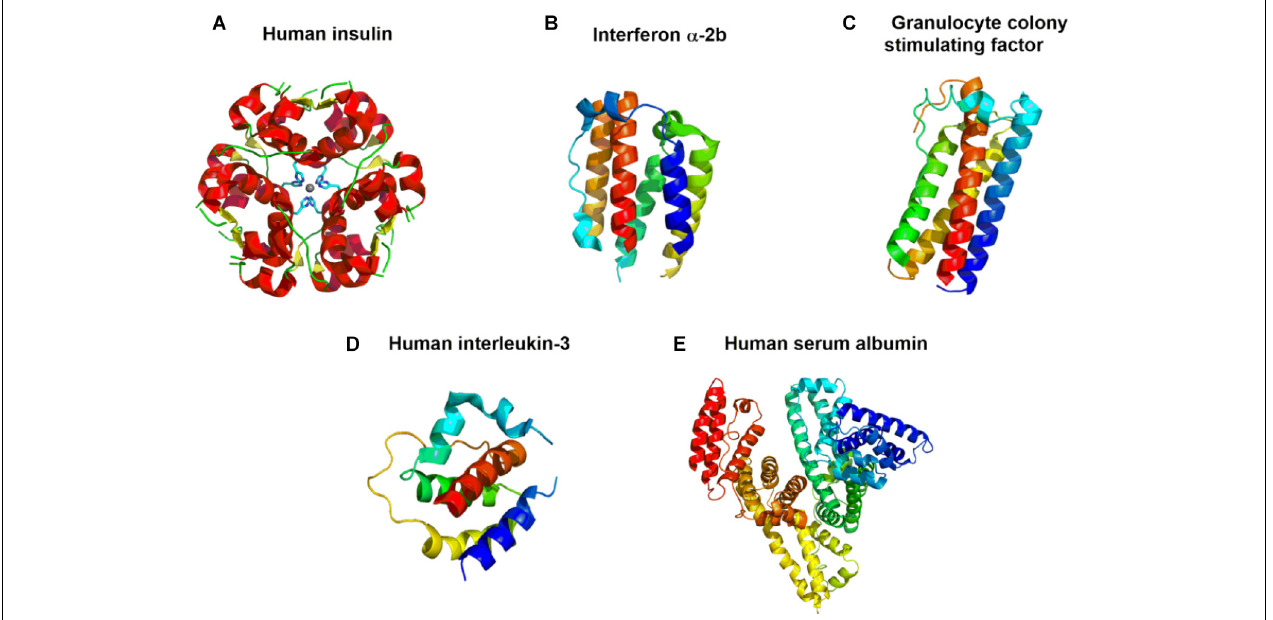
FIGURE 4 | Crystal structures of (A) recombinant human insulin (Humulin R (cid:13) ) (PDB 4F0N) (Favero-Retto et al., 2013); (B) interferon (IFN) α -2b (PDB 3SE3) (Thomas et al., 2011); (C) granulocyte colony growth factor pegfilgrastim (Neupeg R (cid:13) ) (PDB 1HRG) (Hill et al., 1993); (D) human interleukin-3 (PDB 5UV8) (Broughton et al., 2018); and (E) human serum albumin (Recombumin R (cid:13) and Albucult R (cid:13) ) (PDB 1AO6) (Sugio et al., 1999). The models are colored according to the sequence by a rainbow color from the N-terminus (blue) to the C-terminus